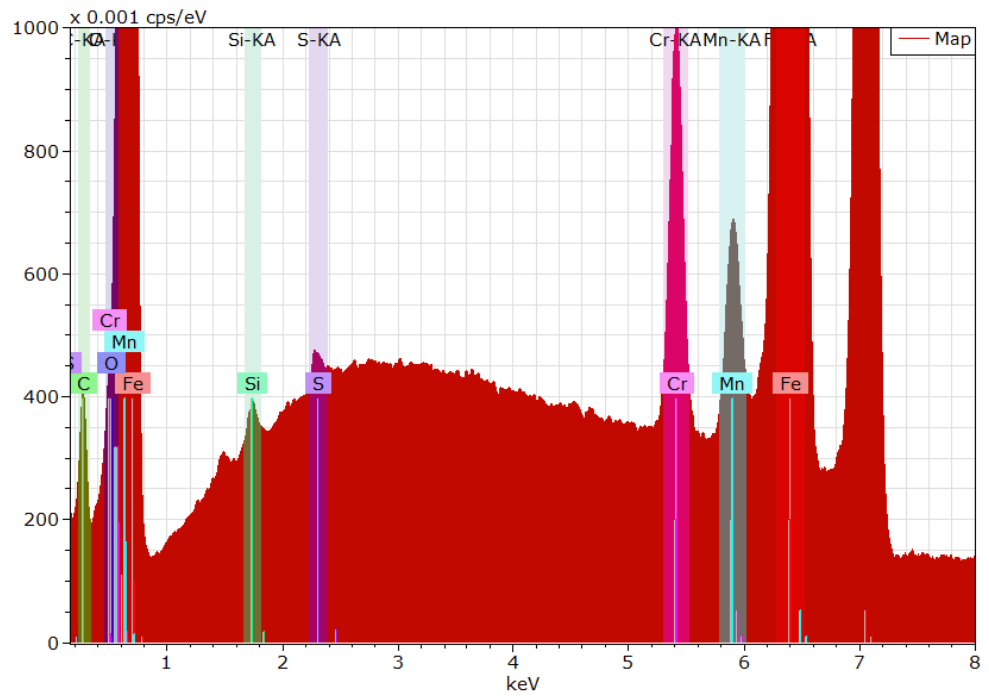
Figure 2. EDS elemental analysis of sample S1 with main energies depicted.